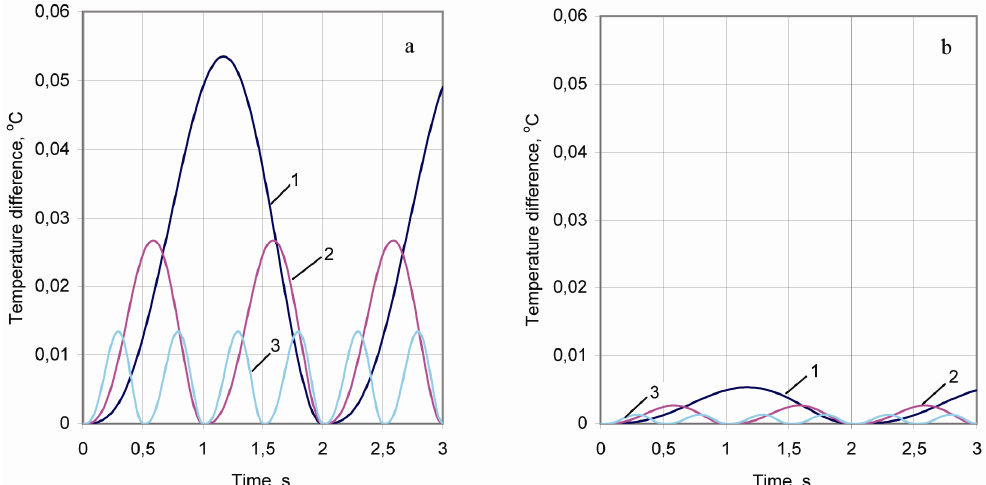
Fig. 6. The dependence of temperature pulsations in plant leaf plates of different thickness on the frequency of plant leaf oscillation when leaf oscillation amplitude β A = 30° in a − leaf plate part whose thickness is 0.1 mm; in b − leaf plate part whose thickness is